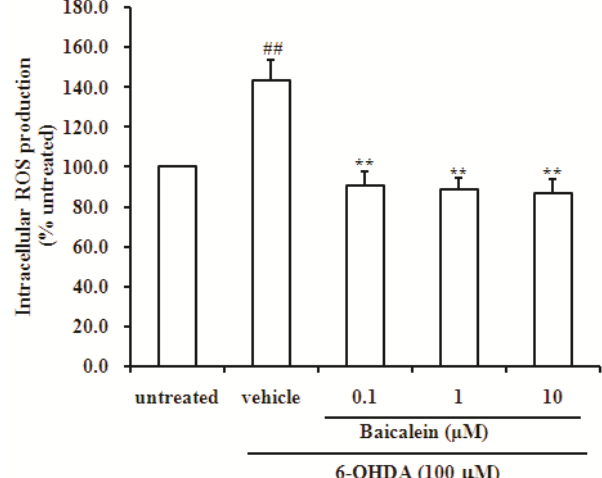
Figure 4. Effect of baicalein on generation of ROS induced by 6-OHDA in SH-SY5Y cells. Data were expressed as percentage of untreated